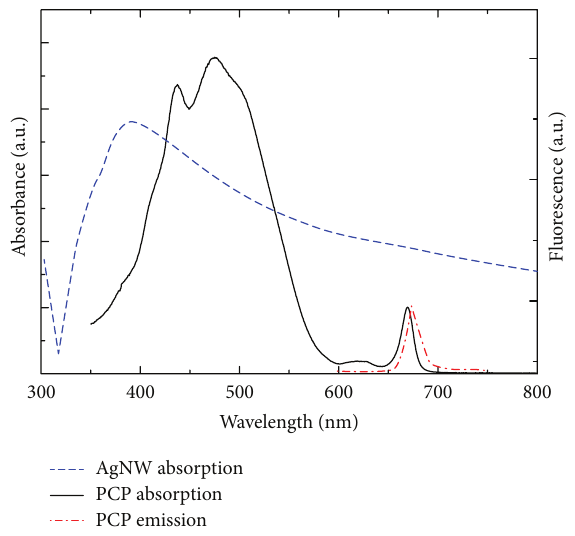
Figure 1: Extinction spectrum of silver nanowires compared with the absorption and emission of the PCP complexes at room tem- perature. All spectra were measured in solution, and the excitation wavelength for collecting fluorescence was 480 nm.